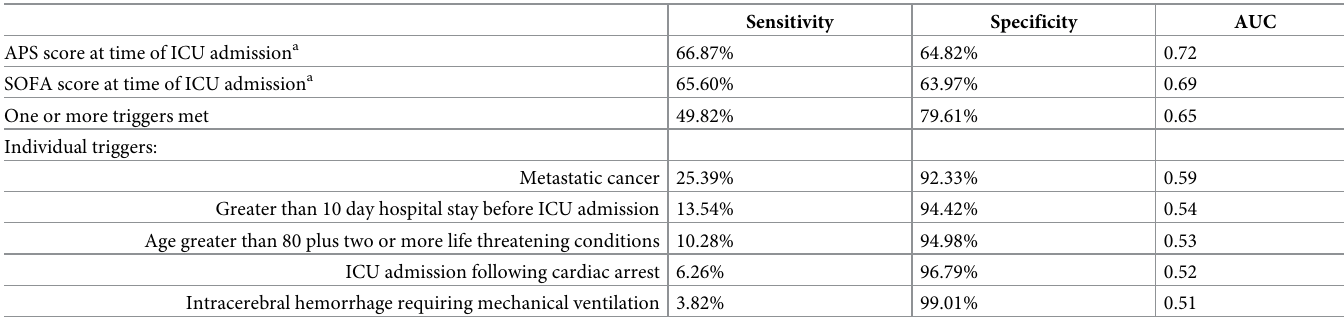
Table 3. Accuracy of mortality-based triggers and severity of illness scores for predicting specialty palliative care consultation in the intensive care